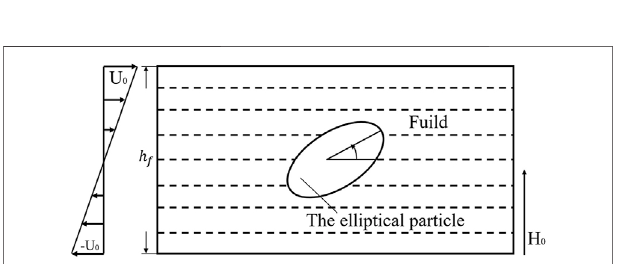
FIGURE 13 | An ellipsoidal particle in the two-dimensional shear fl ows under uniform magnetic fi eld.